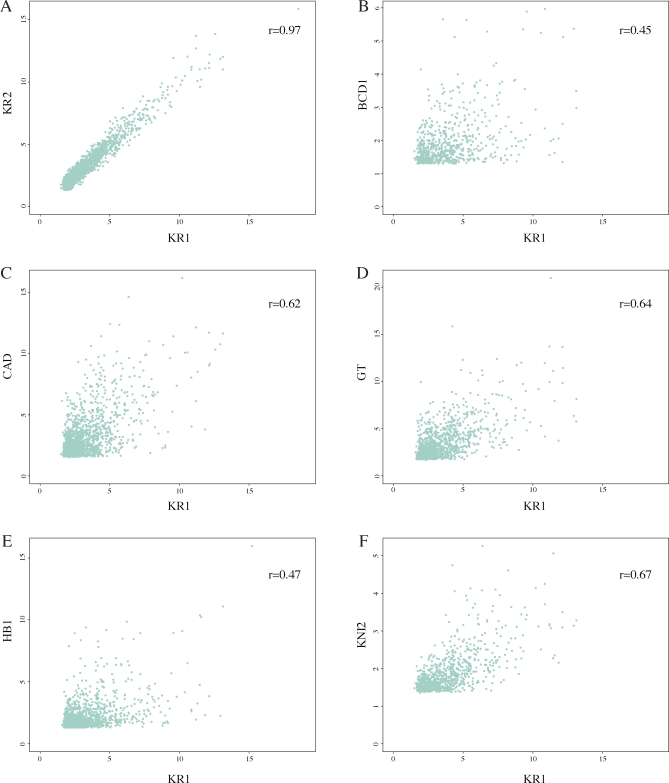
Factors Bind with Quantitatively Different Specificities to Shared Target RegionsCorrelation of primary peak score between overlapping (within 500 bp) primary peaks. (A) shows the correlation of KR1 1% FDR peaks versus KR2 25% FDR peaks; (B–F) show KR1 1% FDR against BCD1, CAD, GT, HB1, and KNI2 25% FDR primary peaks, respectively. The Pearson correlation coefficients (r) for each comparison are shown in the top right of each panel.